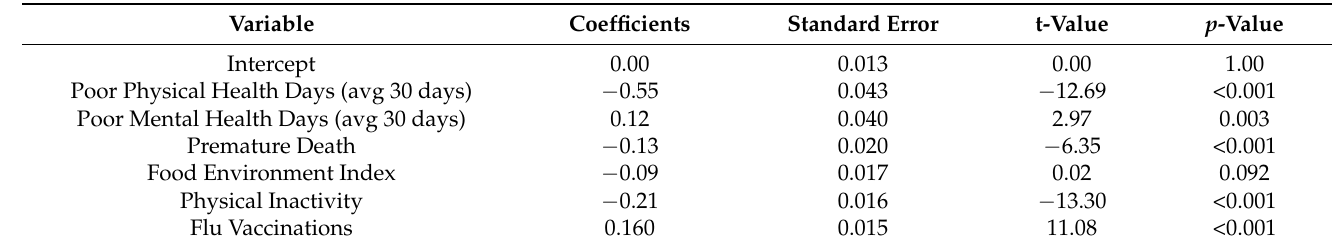
Table 2. Results from the ordinary least squares regression for predicting educational attainment. N = 3003 observations; R-squared =